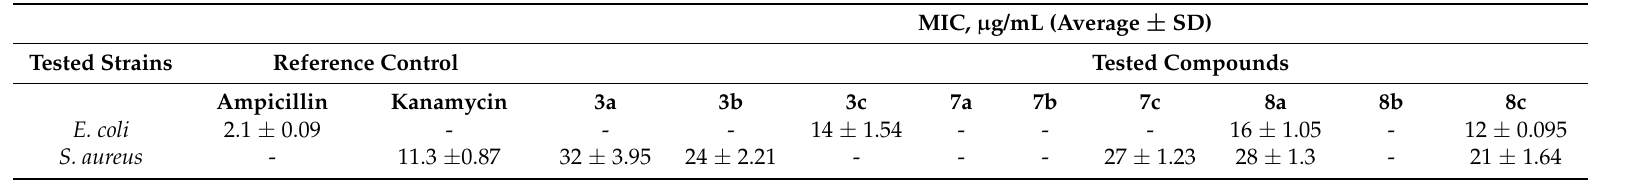
Table 1. The minimum inhibitory concentration (MIC) of effective tested compounds and positive reference